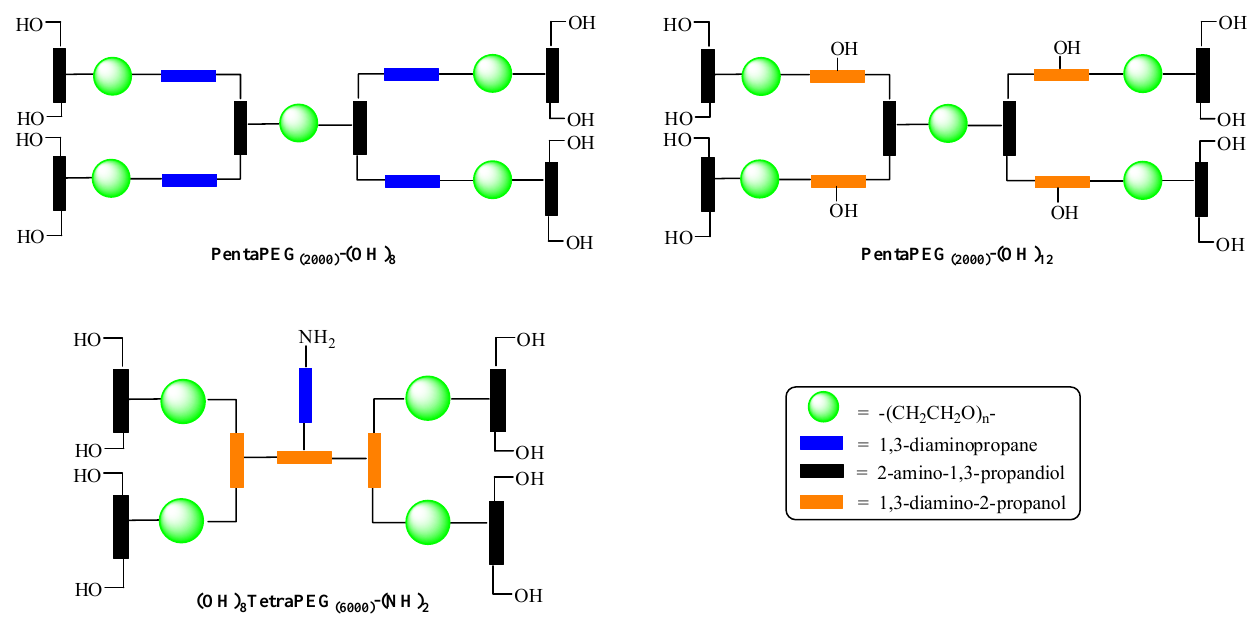
Figure 2. Structures of some relevant MultiPEGs bearing different number of functional groups for each polymeric